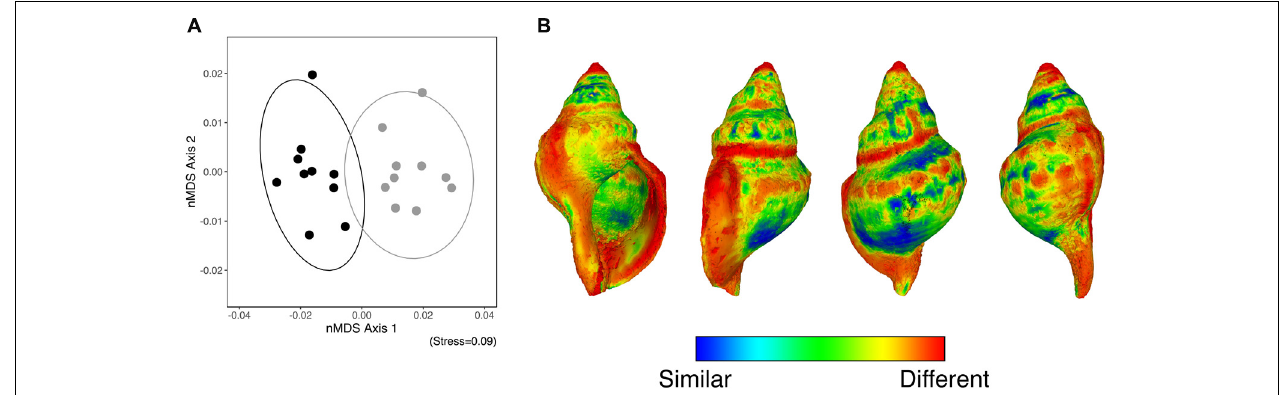
FIGURE 2 | (A) An nMDS ordination of the surface shape differences [based on the Generalized Procrustes Surface Analysis (GPSA)] between the control p CO 2 (solid black) and elevated p CO 2 (solid grey) individuals. (B) A heatmap of the differences in the shape of the surface based on the GPSA which highlights where the changes are most prominent between the elevated- and the mean shape of the reference p CO 2 individuals (where blue indicates a similar shape, and red indicates a greater degree of change).